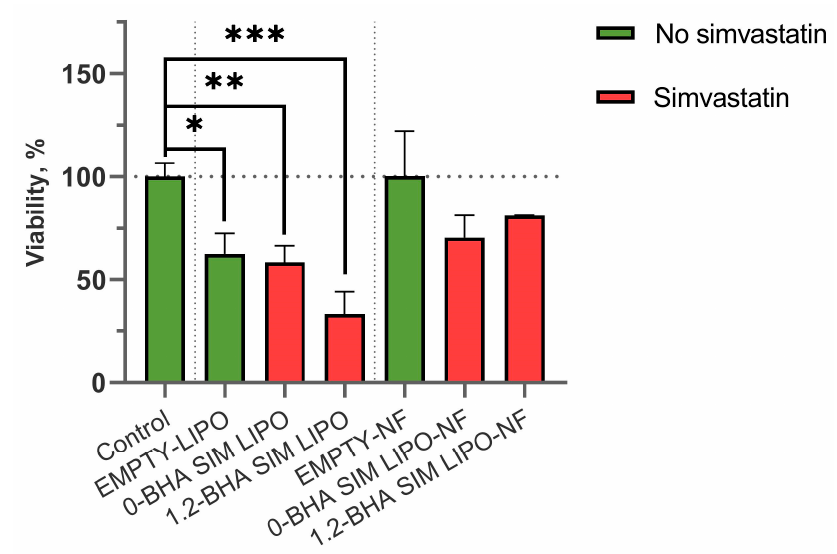
Figure 7. The effects of the formulations containing 4 µ g/mL SIM on the viability of PBMCs. The Figure 7. The e ff ects of the formulations containing 4 µg/mL SIM on the viability of PBMCs . The data are presented as means ± SD ( n = 3). * p < 0.05, ** p < 0.01, *** p < data are presented as means ±SD ( n = 3). * p < 0.05, ** p < 0.01, *** p < 0.001.